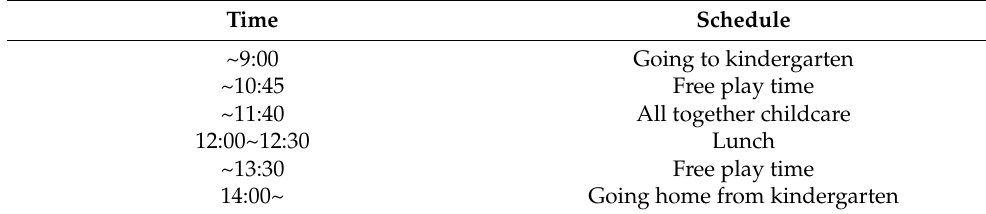
Table 1. Kindergarten daily